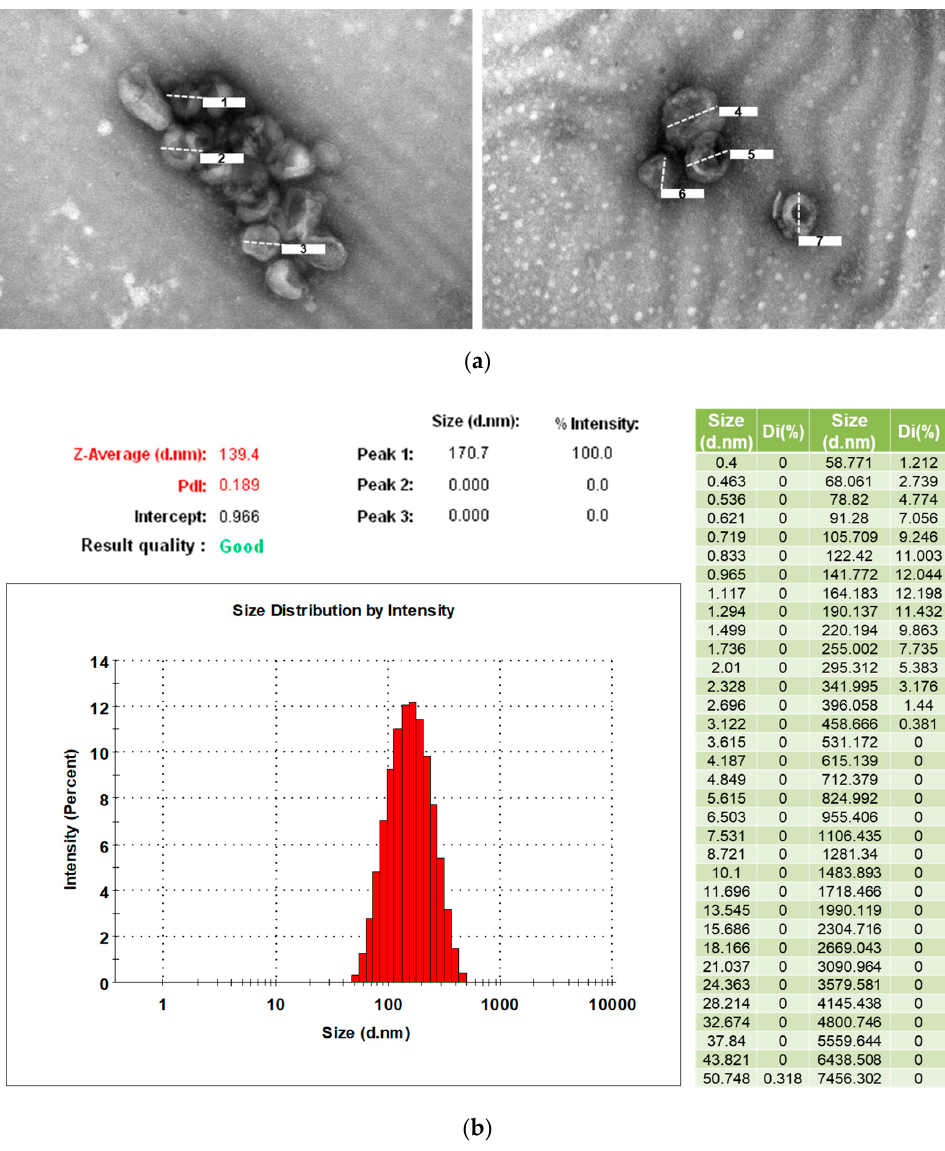
Figure 1. ( a ) Transmission electron microscopy (TEM) images demonstrate the characteristics of exosomes. Scale bars: (1) 79.3 nm, (2) 77.3 nm, (3) 92.4 nm, (4) 113 nm, (5) 92.3 nm, (6) 74.7 nm, (7) 80.6 nm. ( b ) The size distribution of the exosomes extracted from serum.